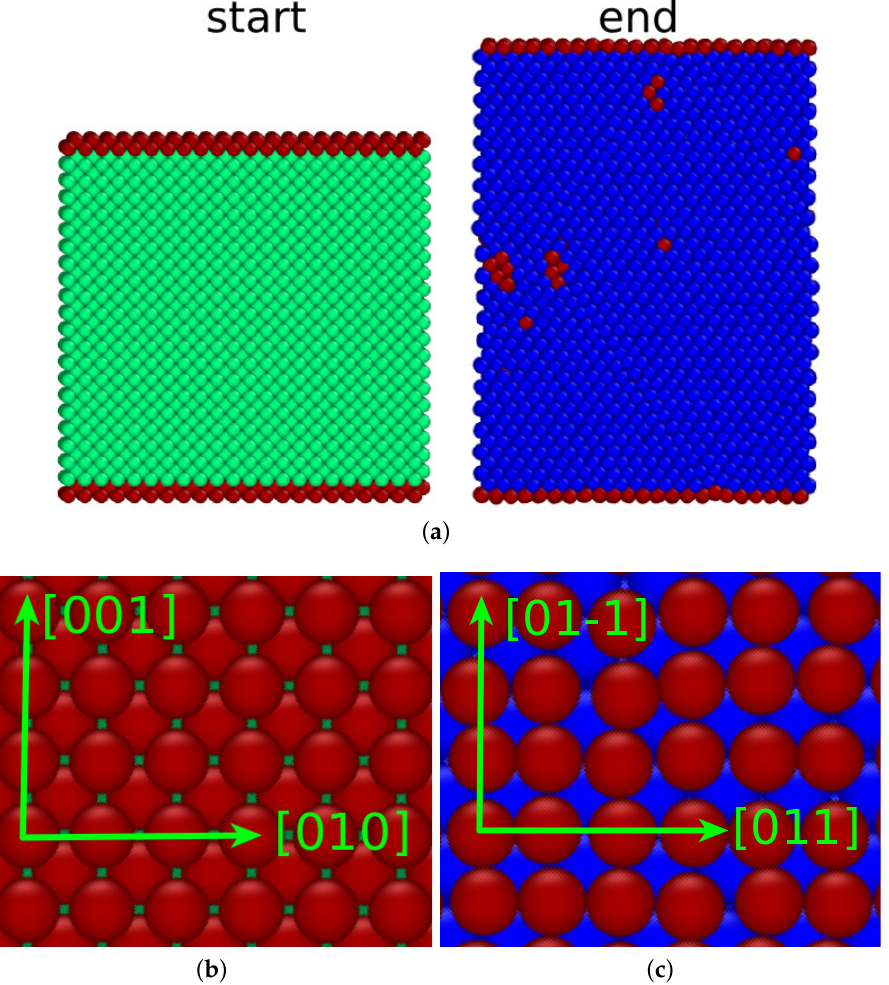
Figure 2. Austenitic transformation of a thin-film bcc Fe slab with a ( 001 ) bcc surface: ( a ) side view of the film before and after the transformation; ( b ) top views of the film before the transformation; and ( c ) top views of the film after the transformation. The green arrows highlight the conserved directions. Colors denote the local lattice structure as in Figure